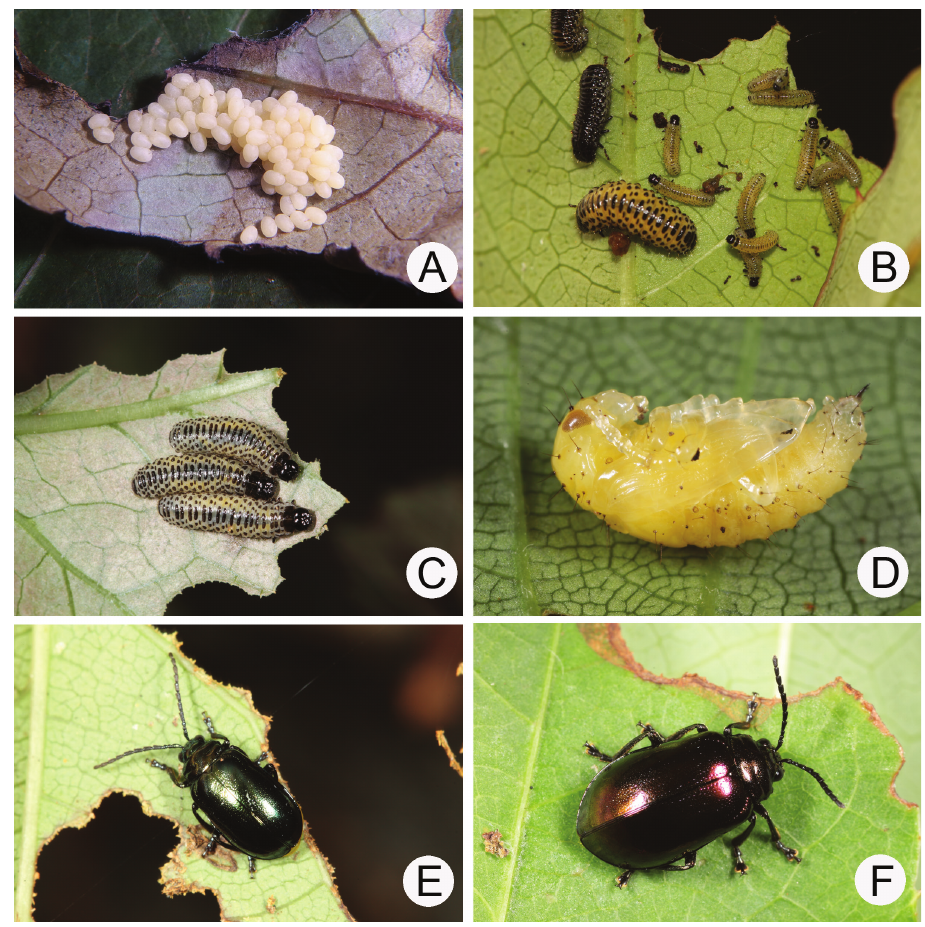
Figures 5. Field photographs of Gallerucida flaviventris (Baly). A Egg mass B Early instar larvae C Ma- ture larvae D Pupa E Adult, typical form F Adult, color